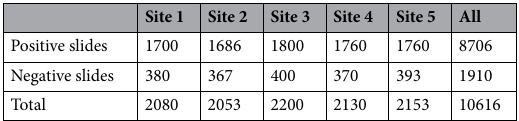
Table 1. Data split of PANDA.